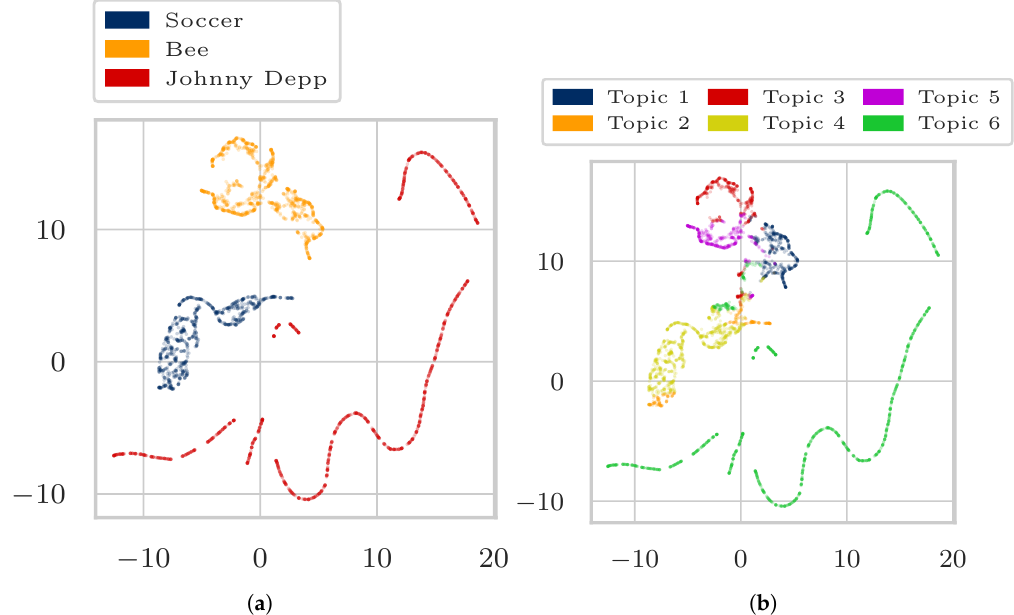
Figure A4. ( a ) 2-dimensional representation of word embeddings A (cid:48) colored by topic assignment. ( b ) 2-dimensional representation of word embeddings A (cid:48) colored by original Wikipedia article assignment (words that occur in more than one article are